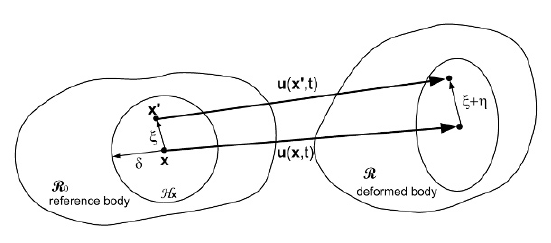
Figure 1. The deformation of a peridynamic